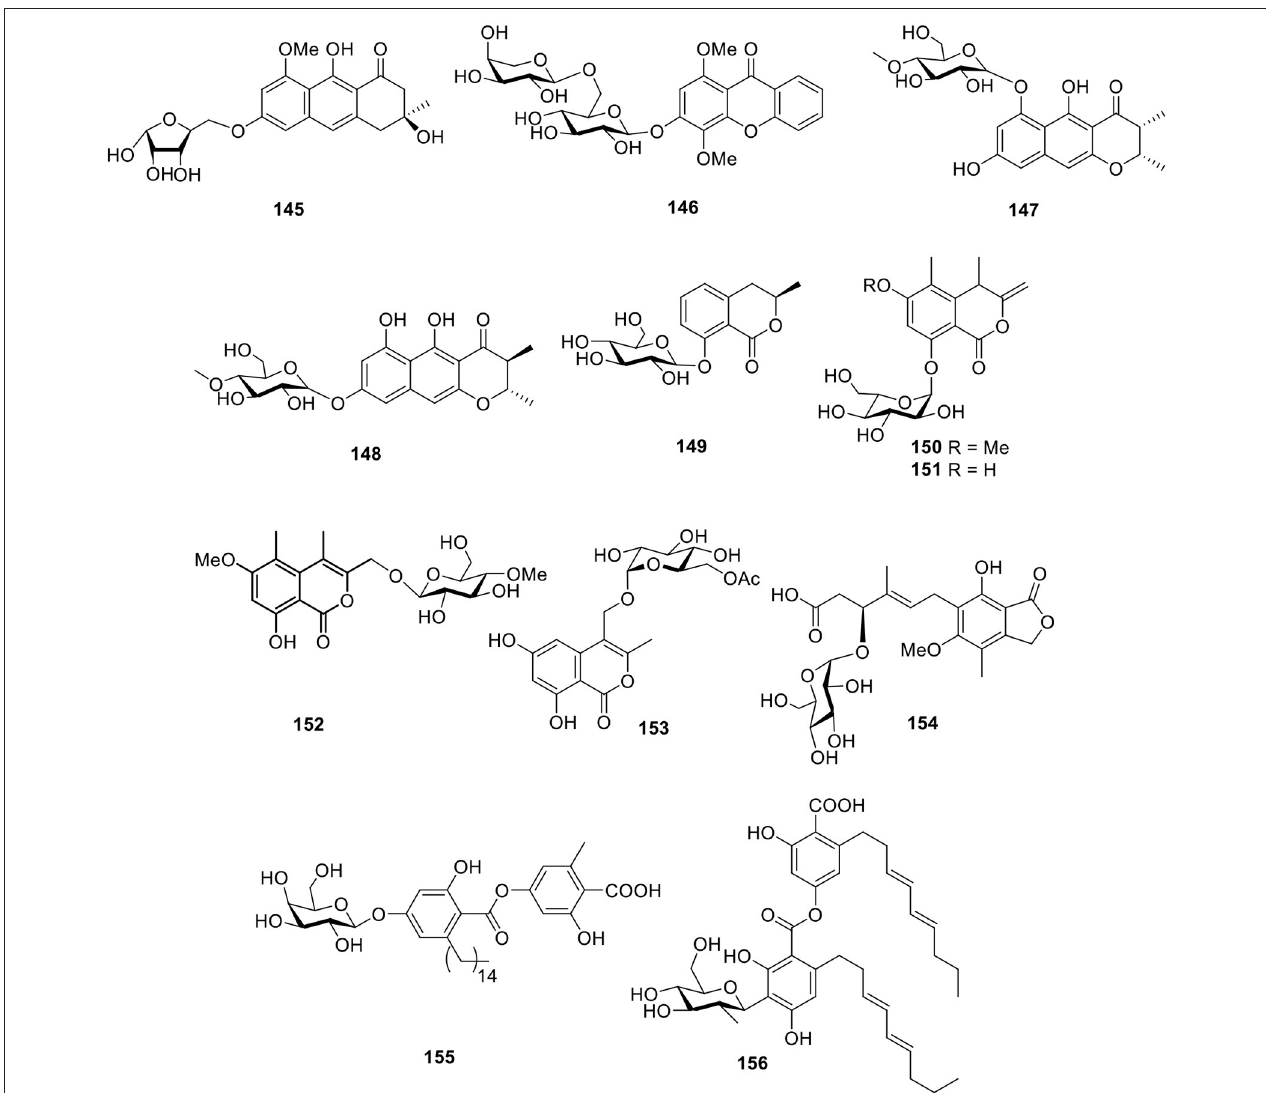
FIGURE 11 | Chemical structures of compounds 145–156 derived from marine-sourced